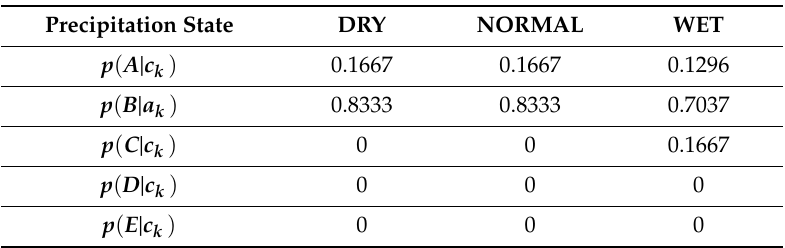
Table 10. Conditional probabilities for precipitation.